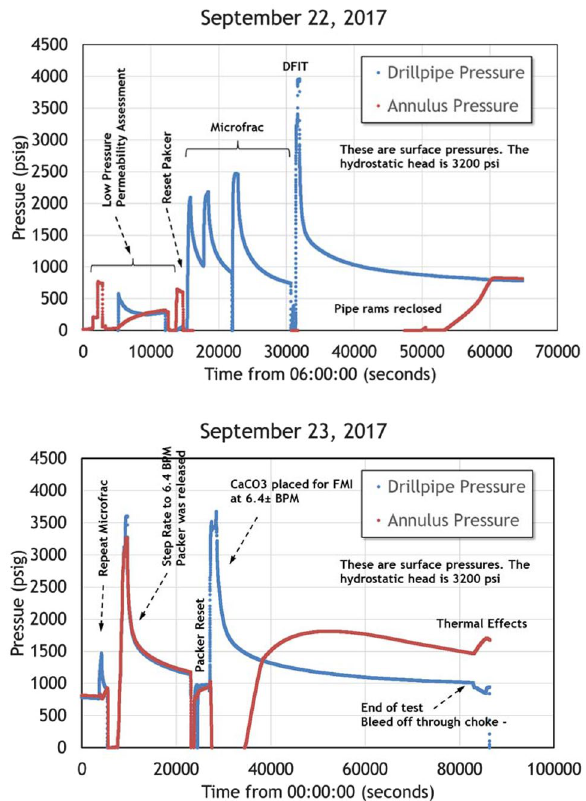
Fig. 1 Surface pressure during the injection campaign. The